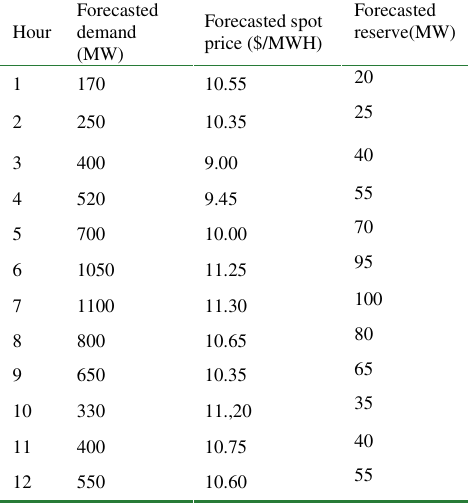
Fig 4. Comparison of Profit between LR-EP & Proposed Method B